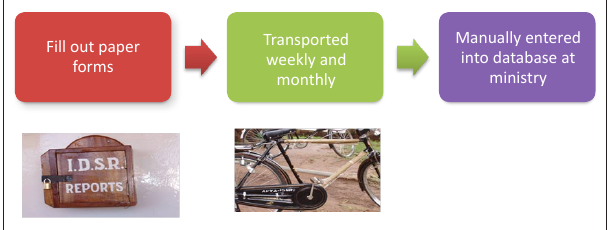
Ministry receives data in near real times